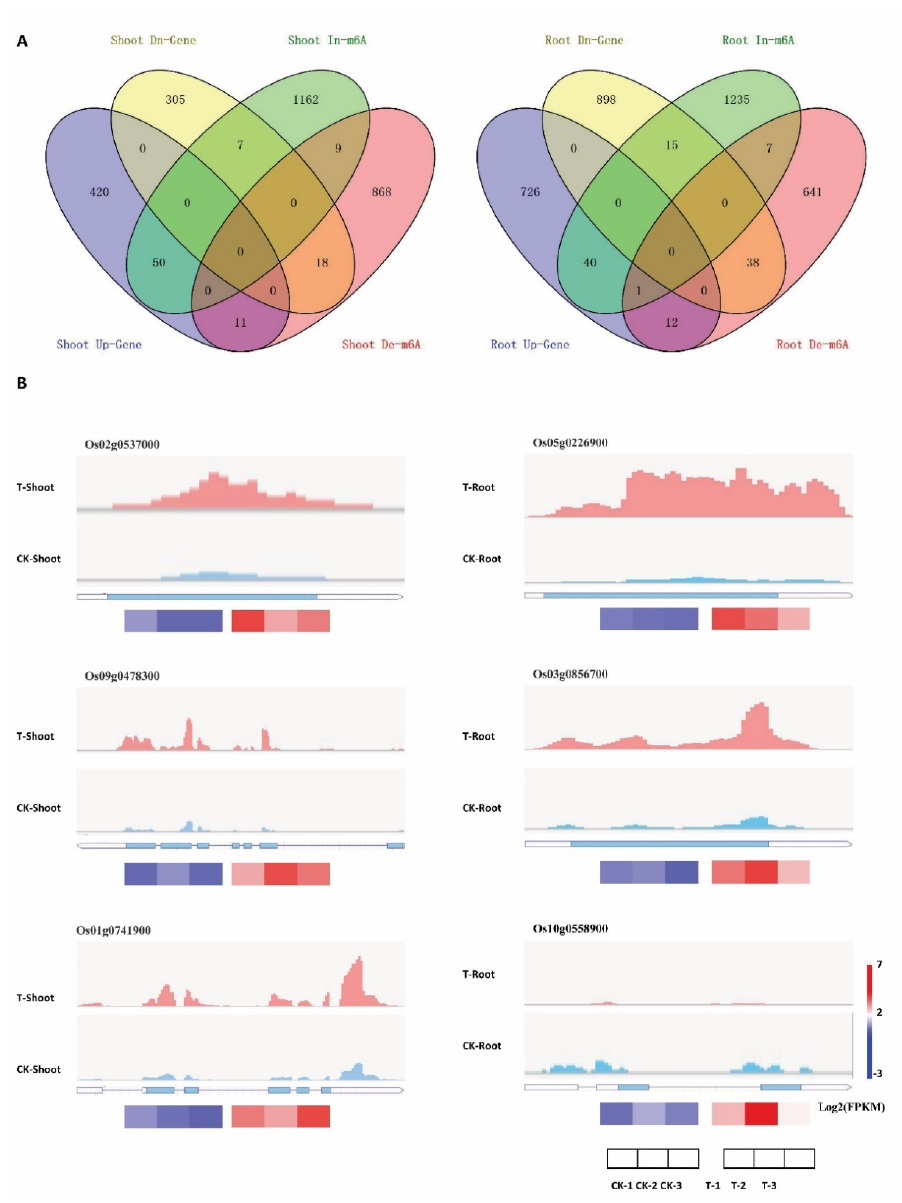
Figure 6. Comparative analysis of the differentially expressed genes and the genes with decreased and increased m 6 A methylation levels in the shoots and roots of FL478 plants under salt stress conditions. ( A ) Venn diagram analysis of the up-regulated (Up-gene)/down-regulated genes (Dn-gene) and the genes with increased/decreased m 6 A levels (In-m 6 A/De-m 6 A) in the shoots and roots under salt stress conditions; ( B ) Peak m 6 A levels and expression patterns of six genes in the shoots and roots under salt stress (T) and control (CK) conditions.